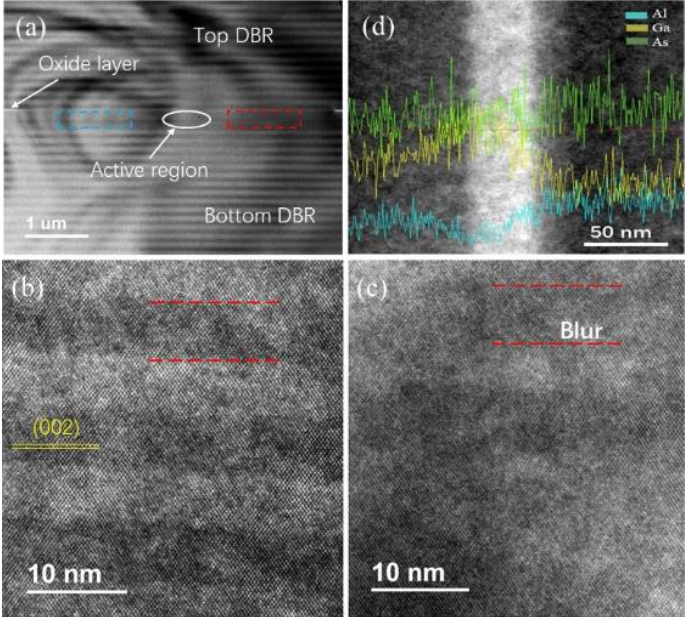
Figure 11. ( a ) TEM image of FIB cross section. ( b , c ) Magnified image of the region of interest in the bule box and the red box. ( d ) EDS line scan image of the active region.